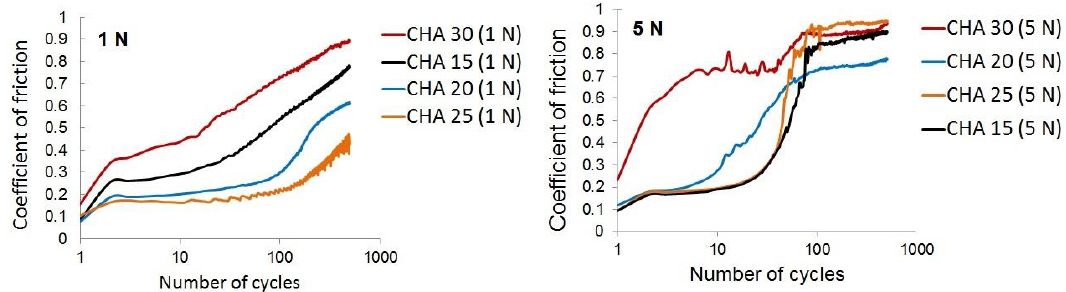
Figure 8. Friction dependence on the coating cycles of CHA layers deposited on the patterned rough surface of stainless steel substrate under ( a ) 1 and ( b ) 5 N loads. Number of layers: 15 layers—CHA 15, 20 layers—CHA 20, 25 layers—CHA 25, and 30 layers—CHA